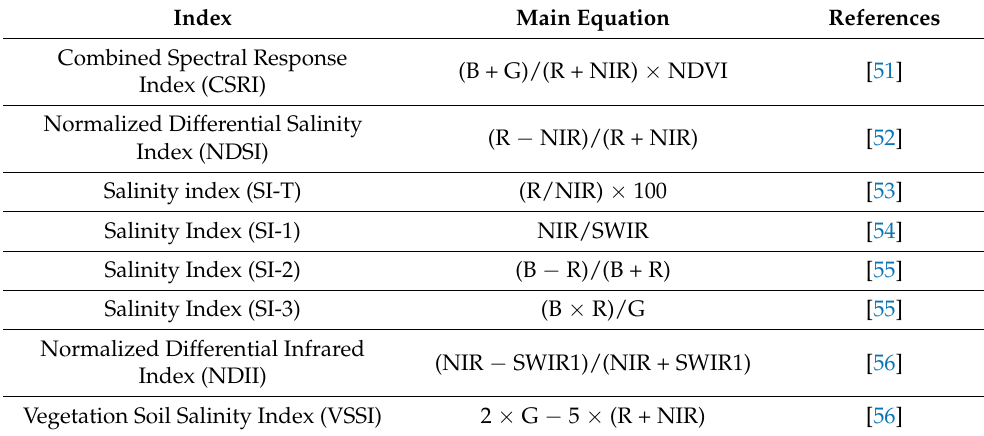
Table 3. The soil salinity indices and their respective equations used in this study.